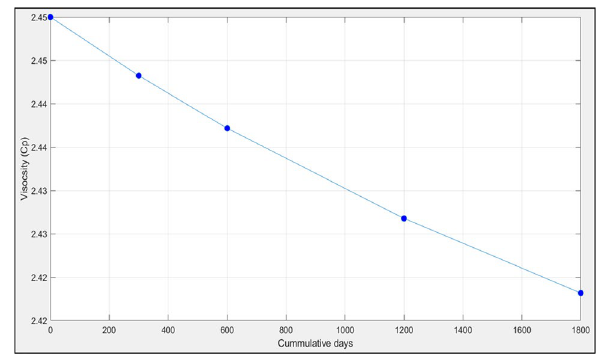
Fig. 2 Graph of the CO Fig. 4 Effect of oil viscosity vs cumulative days of injection 2 equilibrium in the gas-oil phase. Note: filled circle = cumulative injection day 300, filled square = cumula- tive injection day 600, filled triangle = cumulative injection day 1200, filled diamond = cumulative injection day 1800, straight line = phase equilibrium at P = 600 psig, straight with dotted line = phase equi- librium at P = 1200 psig, dotted line = phase equilibrium at P = 2400 psig